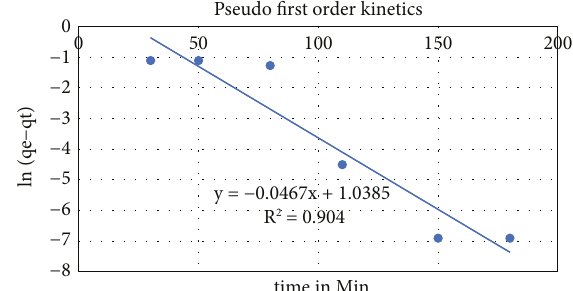
Figure 21: Pseudo-first-order kinetic fit for adsorption of 20ppm of dieldrin solution onto nanocomposite at 27 ° C.